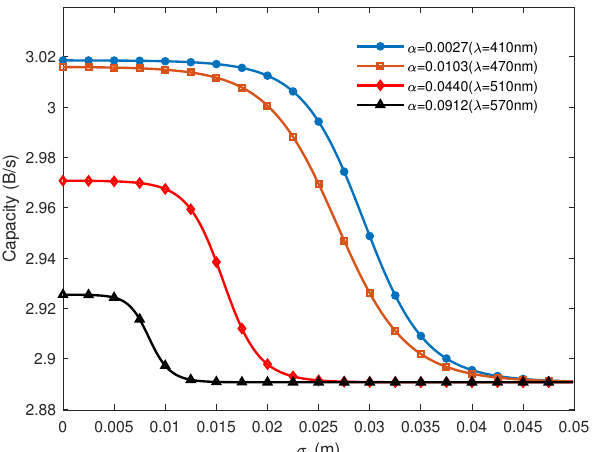
Figure 4. Information capacity of OAM channels versus the inner scale η for the outer scale L 0 .